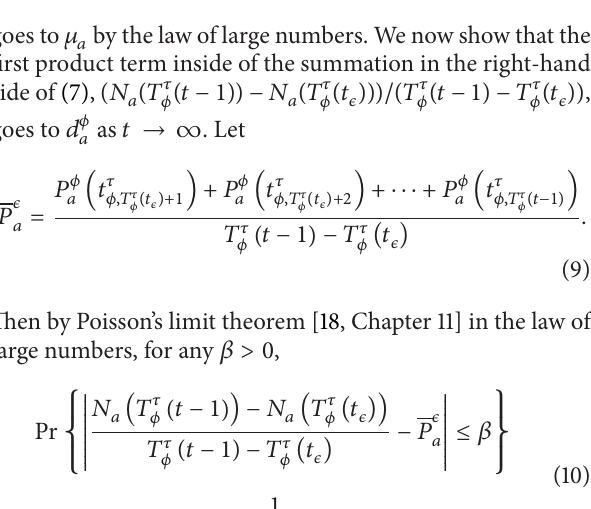
Figure 1: Percentage of selections of the best strategy of (tuned) 𝜖 𝑡 - comb(3 𝜖 𝑡 -greedy strategies) and of (tuned) Exp4/NEXP/EEEs for the distribution ( 0.9, 0.8, 0.8, 0.8, 0.7, 0.7, 0.7, 0.6, 0.6, 0.6